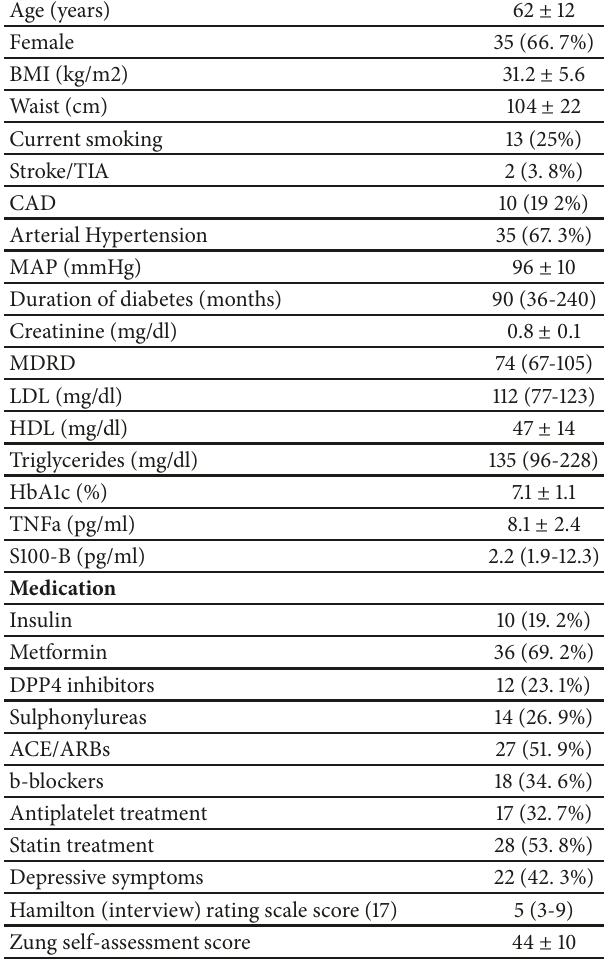
Table 1: Overall population characteristics of patients with Type 2 Diabetes Mellitus